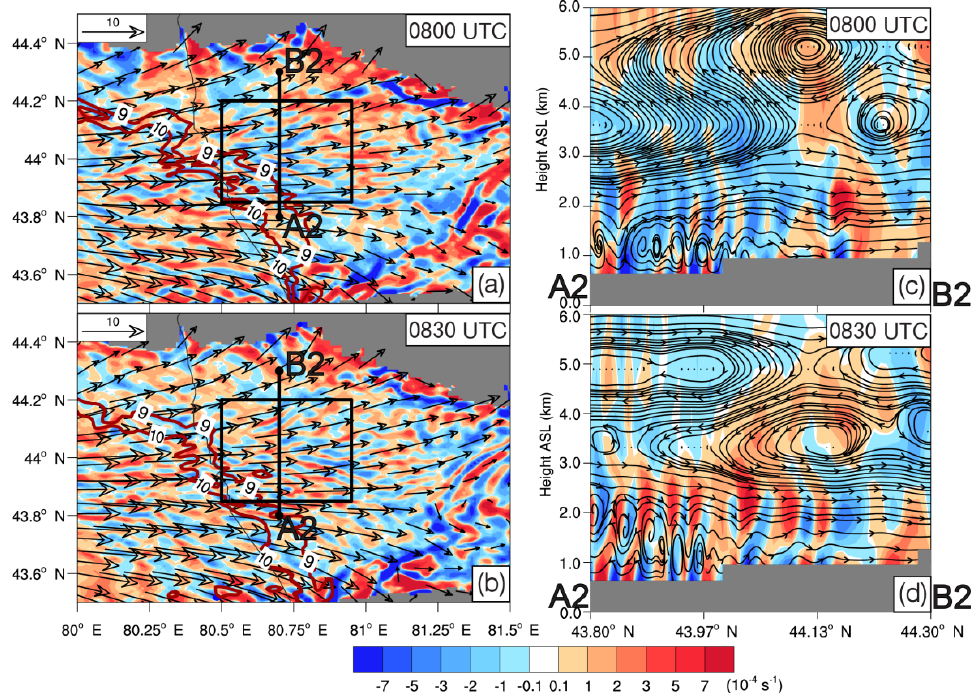
Figure 10. ( a , b ) Simulated horizontal divergence (shading, units: 10 −4 s −1 ), wind field (vectors), and horizontal velocity (thick brown line, unit: m s −1 ) at 1500 m (ASL) on 17 June 2016, the dark grey shadings show the area that surface altitude >1500 m (ASL). The black solid rectangle area denotes the area analyzed in Figure 11a–c. ( c , d ) Vertical cross section of horizontal divergence (shading, units: 10 −4 s −1 ) and wind stream (stream lines) along the line segment A2B2 which located in ( a , b ). The specific time is shown in the upper right corner of each panel, and the dark grey shadings show the area below ground.